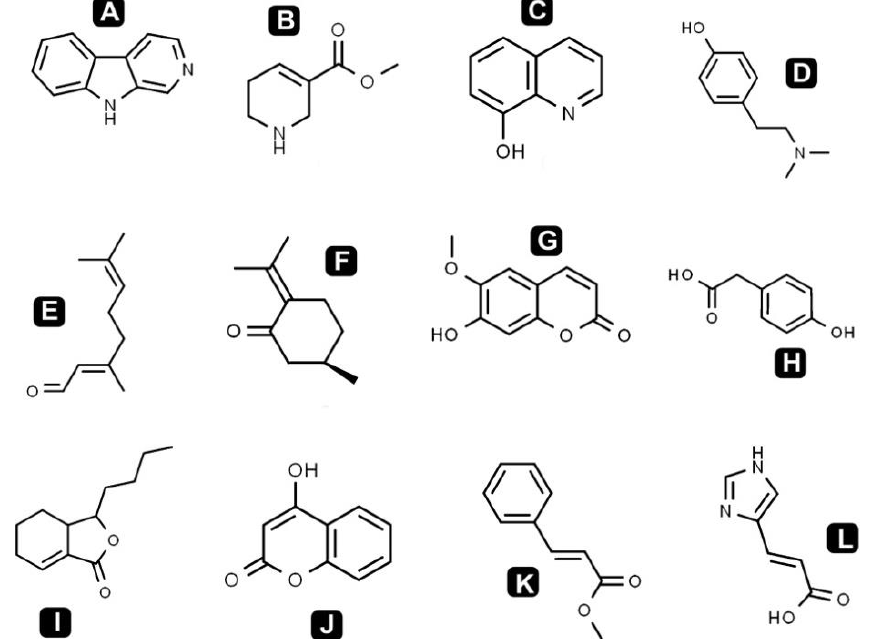
Figure 6. Chemical structures of the identified alkaloids, terpenoids, coumarins, benzenoids, esters and monocarboxylic acid compounds in S. repanda crude extract. A. Norharman B. Guvacoline C. 8-Hydroxyquinoline D. Hordenine E. Citral F. Pulegone G. Scopoletin H. 4-Hydroxyphenylacetic acid I. Sedanolide J. 4-Hydroxycoumarine K. Methylcinnamate L. Urocanic acid.